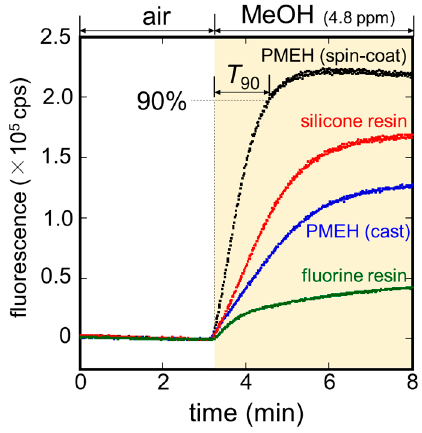
Figure 4. Sensor responses to 4.8 ppm MeOH vapor from the MeOH bio-sniffer, which employed four different waterproof treatments (spin-coating PMEH, casting PMEH, and spraying silicone or fluorine resins) on the gas-phase side of the AOD-FALDH